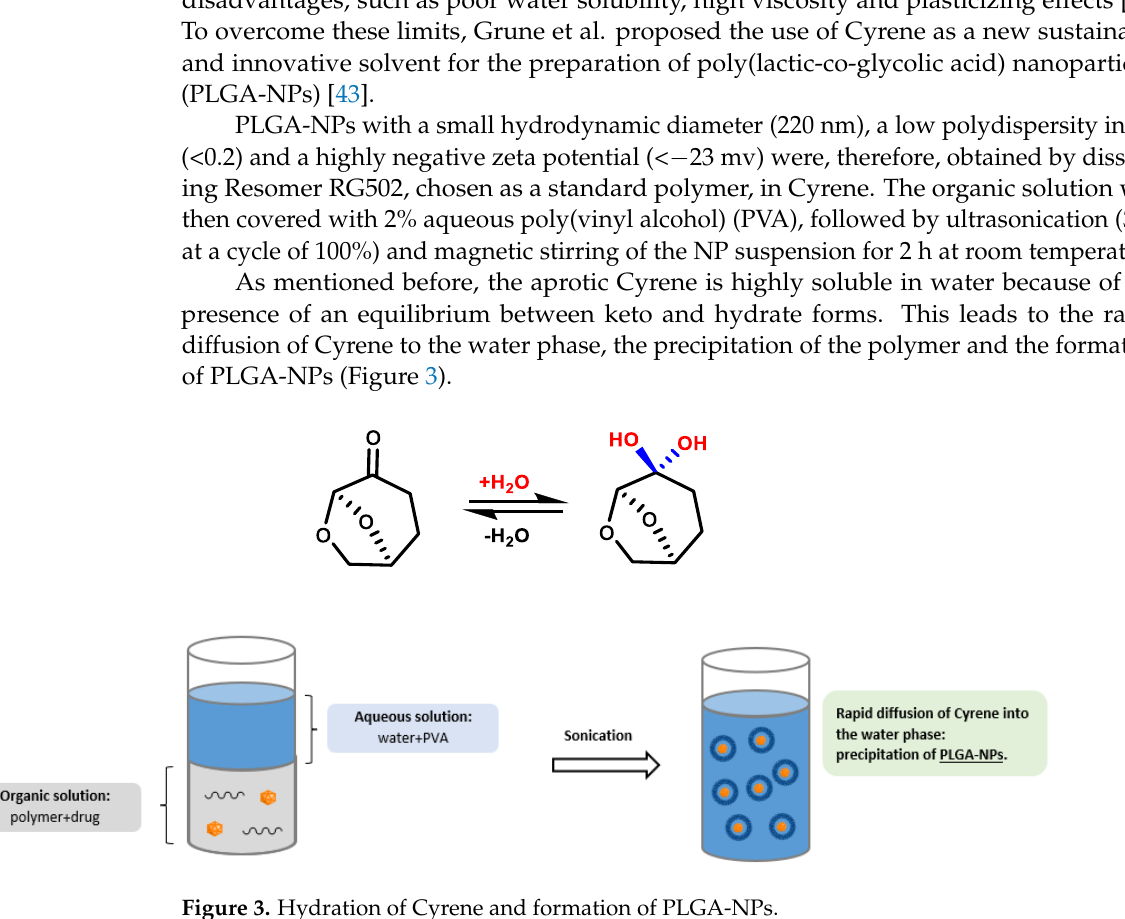
Figure 3. Hydration of Cyrene and formation of PLGA-NPs.